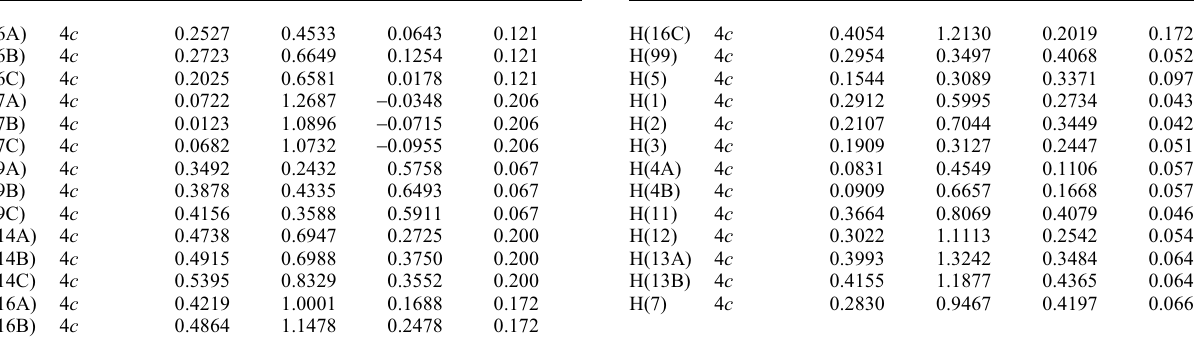
Table 3. Atomic coordinates and displacement parameters (in Å 2 ) .